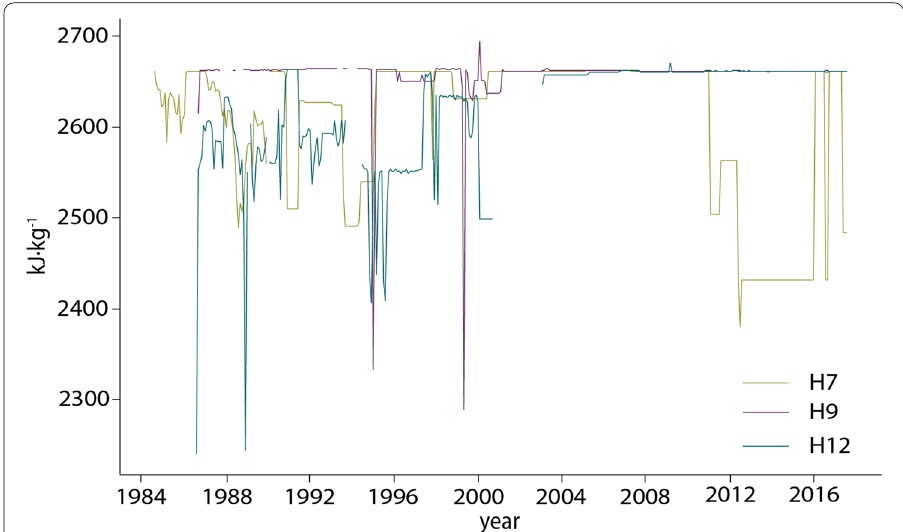
Fig. 2 Extraction history of the most productive wells of the